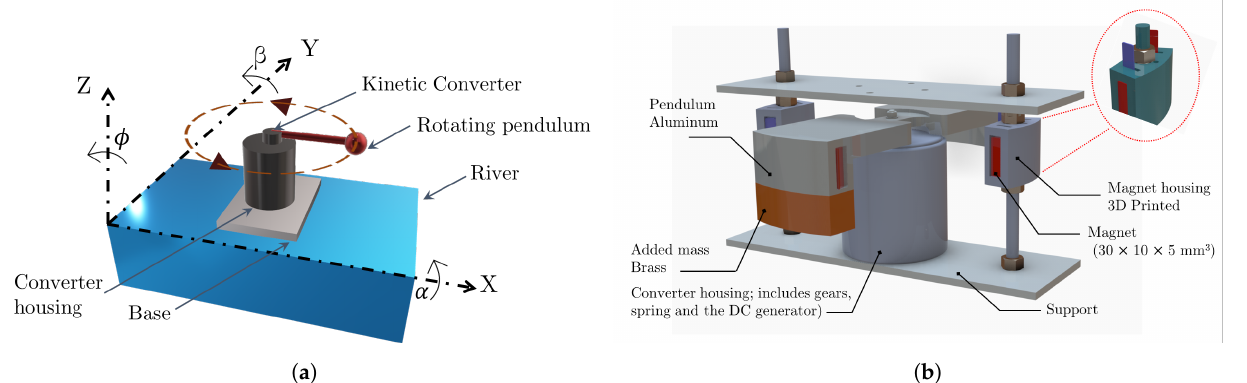
Figure 1. ( a ) Schematic of a pendulum-based kinetic converter on the river, ( b ) improved pendulum design for river current energy